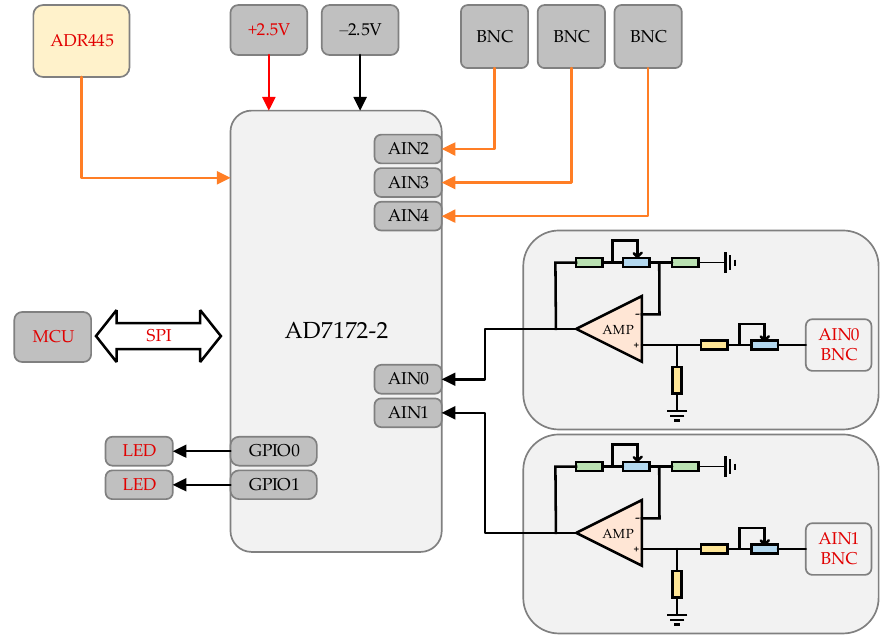
Figure 6. The functional block diagram of the collection board.